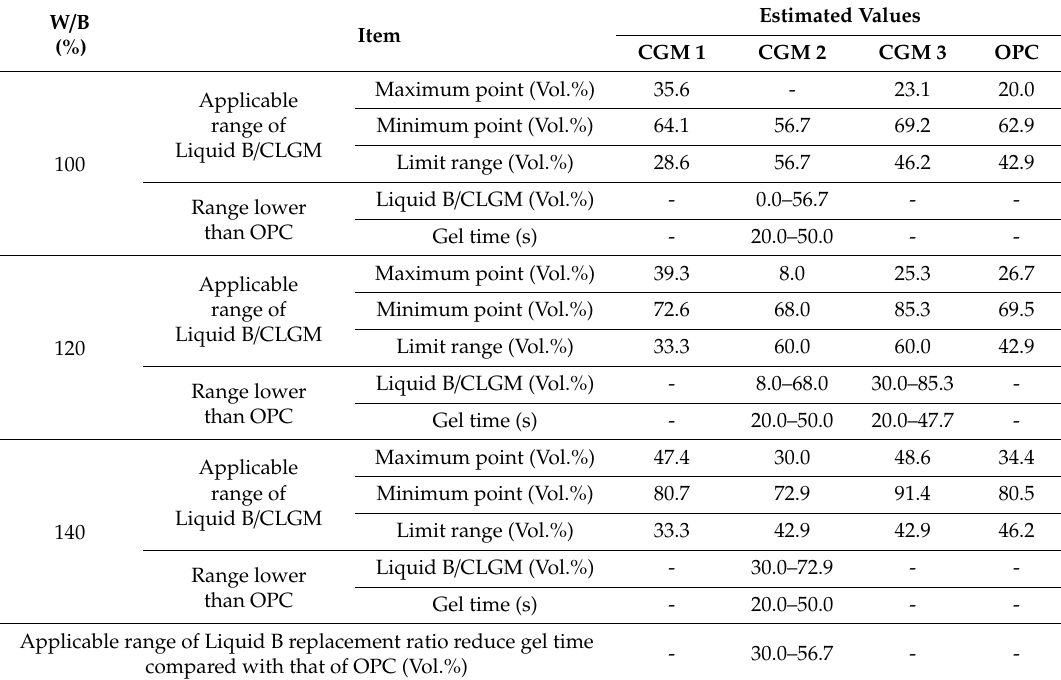
Table 8. Estimated values of gel time according to volume replacement ratio of Liquid